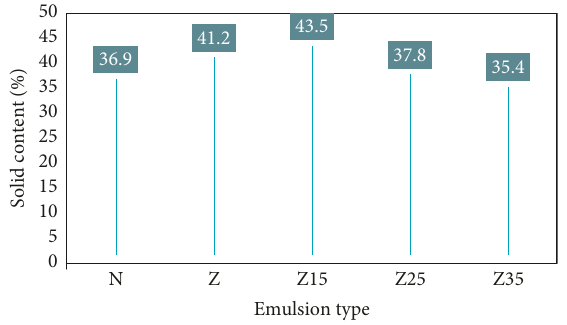
Figure 1: Solid content of emulsion.